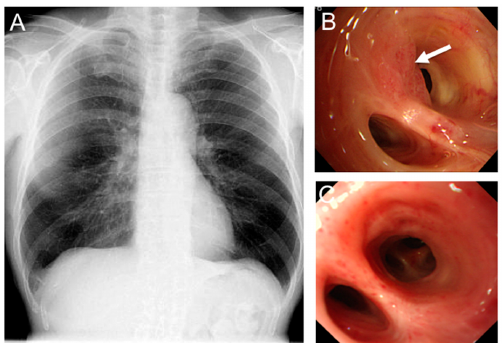
Figure 1. Photodynamic therapy (PDT) for radiographically occult early stage lung cancer. ( A ) A 65-year-old male presented with abnormal sputum cytology and normal chest X-ray; ( B ) Bronchoscopy revealed an endobronchial abnormality at the orifice of the left upper division anterior segmental bronchus (arrow). Biopsy was positive for squamous cell carcinoma; and ( C